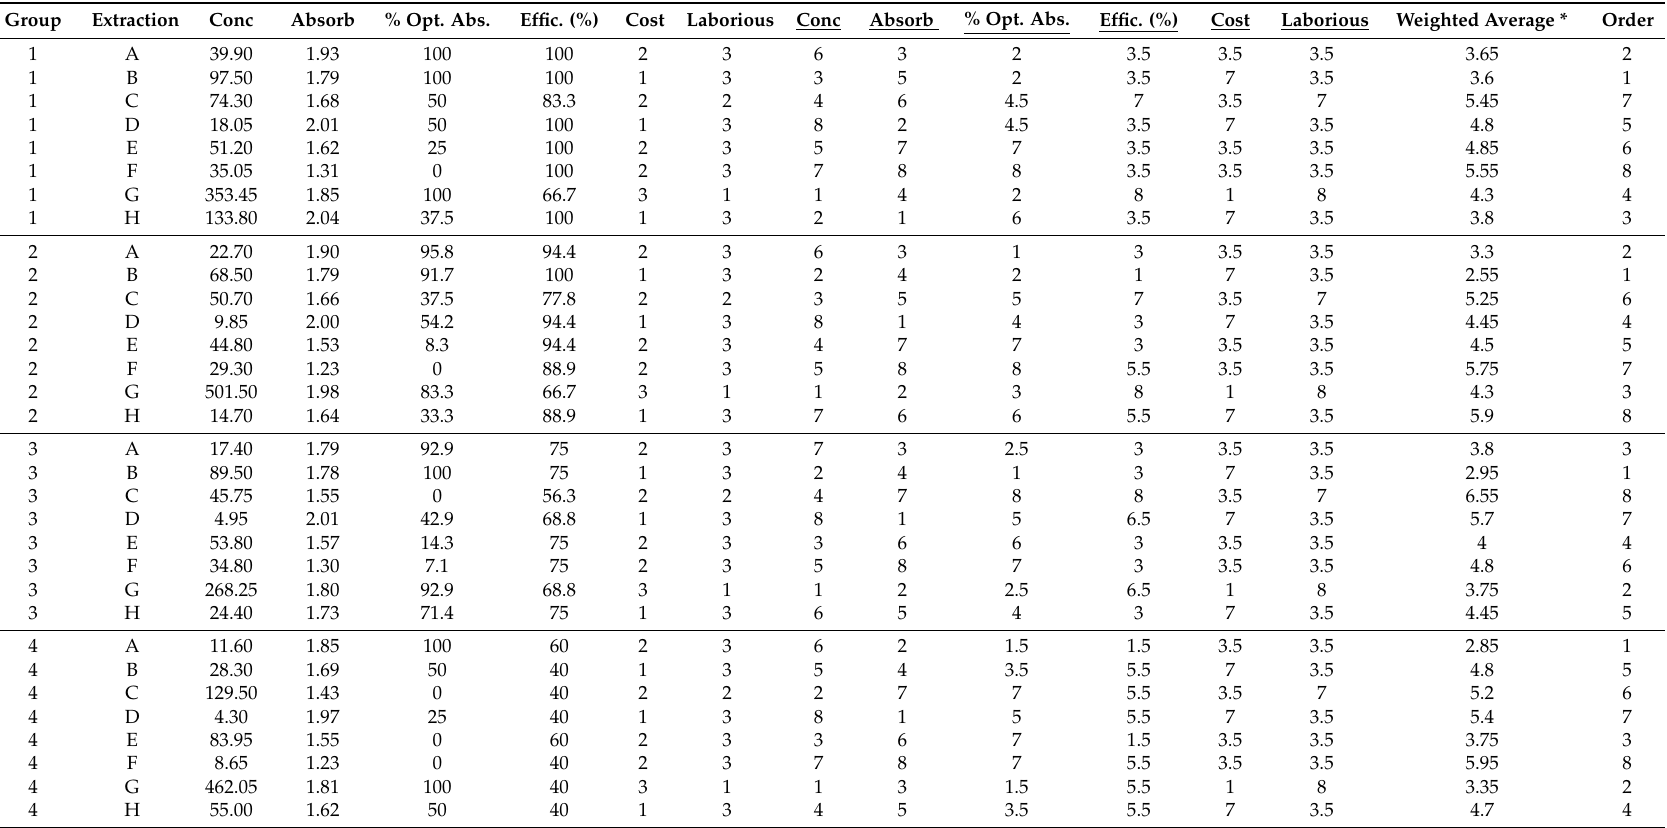
Table 1. Comprehensive evaluation of individual extraction methods; A—DNeasy Blood and Tissue Kit (Qiagen), B—DNeasy mericon Food Kit (Qiagen), C—Chemagic DNA Tissue 10 Kit (PerkinElmer), D—Food DNA Isolation Kit (Norgen Biotek), E—UltraPrep Genomic DNA Food Mini Prep Kit (AHN-Bio), F—High Pure